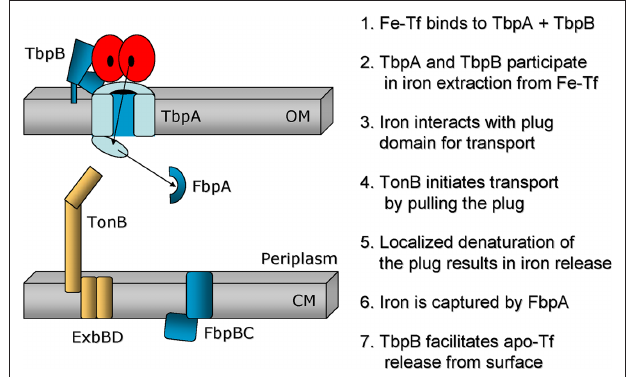
Figure 3 | Model of the mechanism of iron transport from transferrin through the gonococcal outer membrane. TbpA is shown as a bisected barrel with an amino-terminal plug domain exposed in the periplasm. TbpB is shown as a bi-lobed protein protruding from the gonococcal cell surface, tethered to the outer membrane by an amino-terminal lipid moiety. Human transferrin is shown as a bi-lobed structure, each lobe of which is capable of binding an atom of iron. Seven putative steps in iron acquisition from transferrin are listed on the right. The arrows depict the direction of iron import and the hypothetical, transient interaction between iron and the